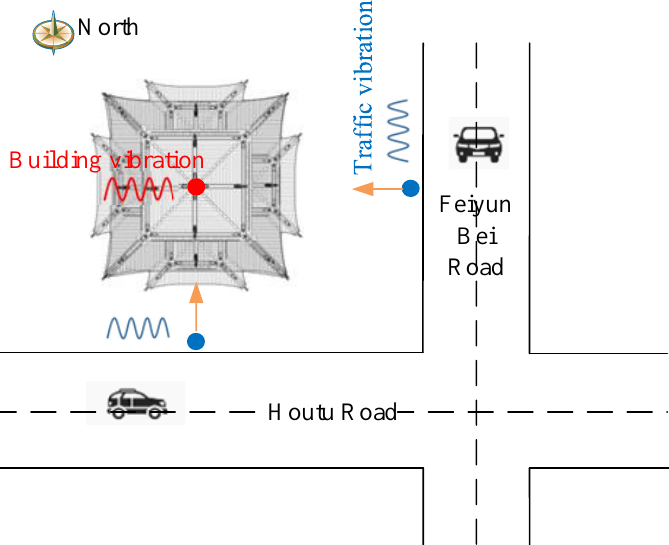
Figure 11. Schematic representation of the traffic environment around the Feiyun Pavilion. Considering the whole media of the vibration transmission is composed of the road, soil, foundation, and superstructure. The measuring points of such a media are particularly arranged as presented in Figures 12 and 13. This is somehow similar to the measurement point arrangement in the “Field test of the RTR function”. In addition to arranging the vibration source replacement point (R) and the first floor measuring points (A − P1, B − P1, C − P1, and D − P1), it is also necessary to arrange the third floor measuring points (A − P2, B − P2, C − P2, and D − P2) at the top of the four corner columns. The third floor measuring points are also exploited to collect the vibration at the highest point of the structure. At the same time, the vibration data of the third floor measuring point can also evaluate the structural safety of the Feiyun Pavilion according to the relevant